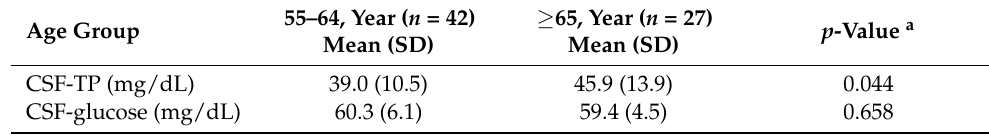
Table 2. The concentrations of CSF-TP and CSF-glucose stratified by age.